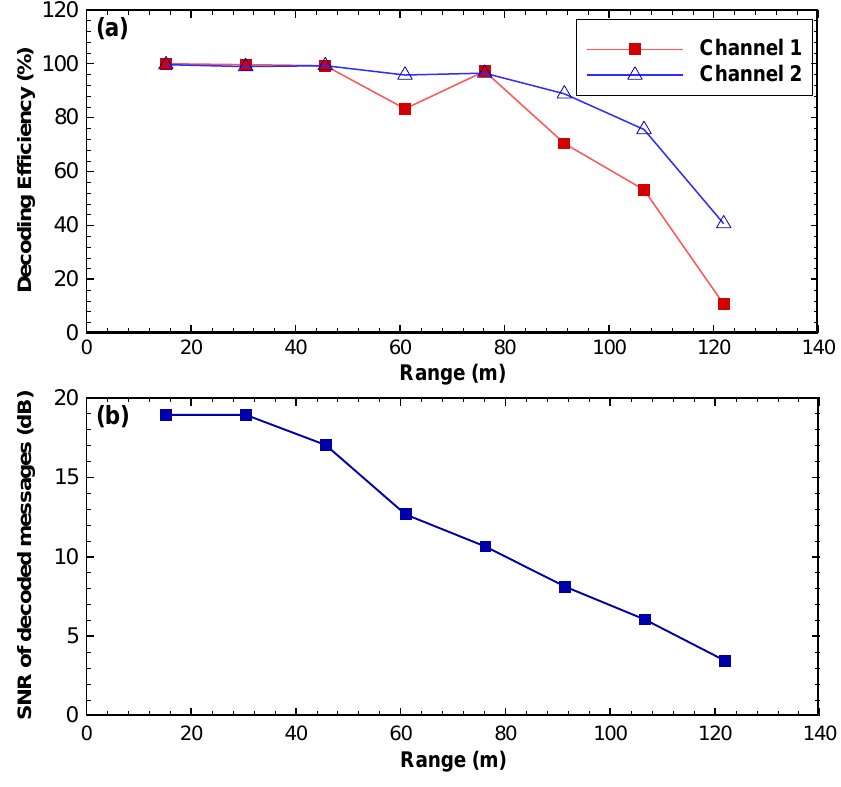
Figure 9. Field performance results at Bonneville Dam spillway: (a) efficiency vs. range; (b) SNR vs.